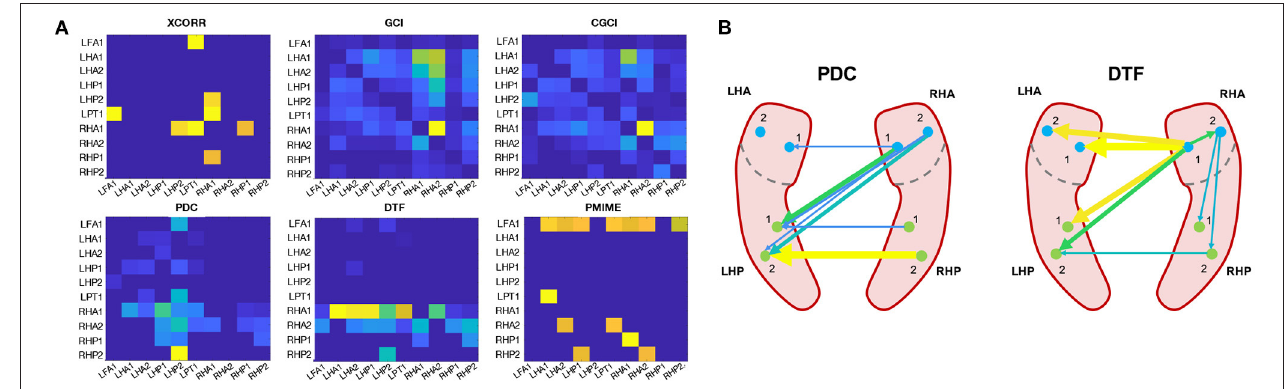
FIGURE 8 | Connectivity results from the sEEG epoch at the beginning of the seizure ( t (B) Simplified schematic representation of the intra- and inter-hippocampal networks based on the PDC and DTF